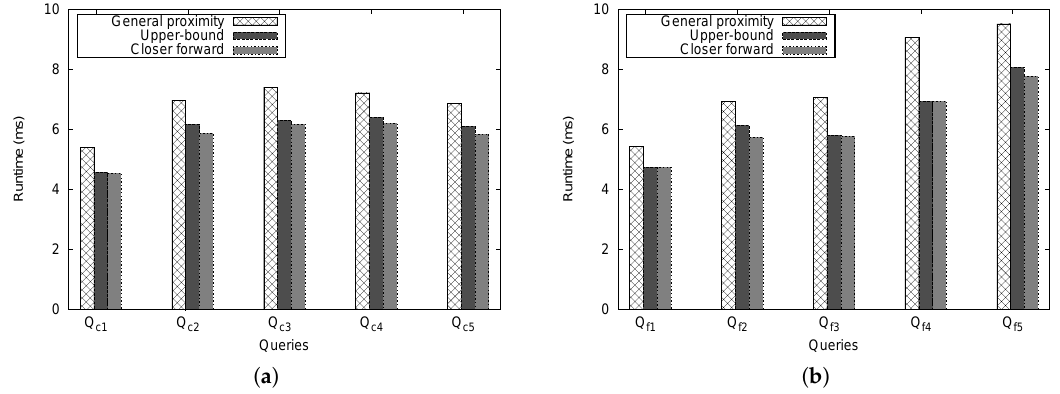
Figure 19. Execution time for general cases. ( a ) close pair queries; ( b ) far pair queries.